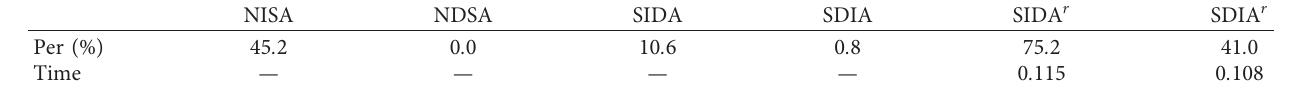
Table 7: Overall view of algorithm results.